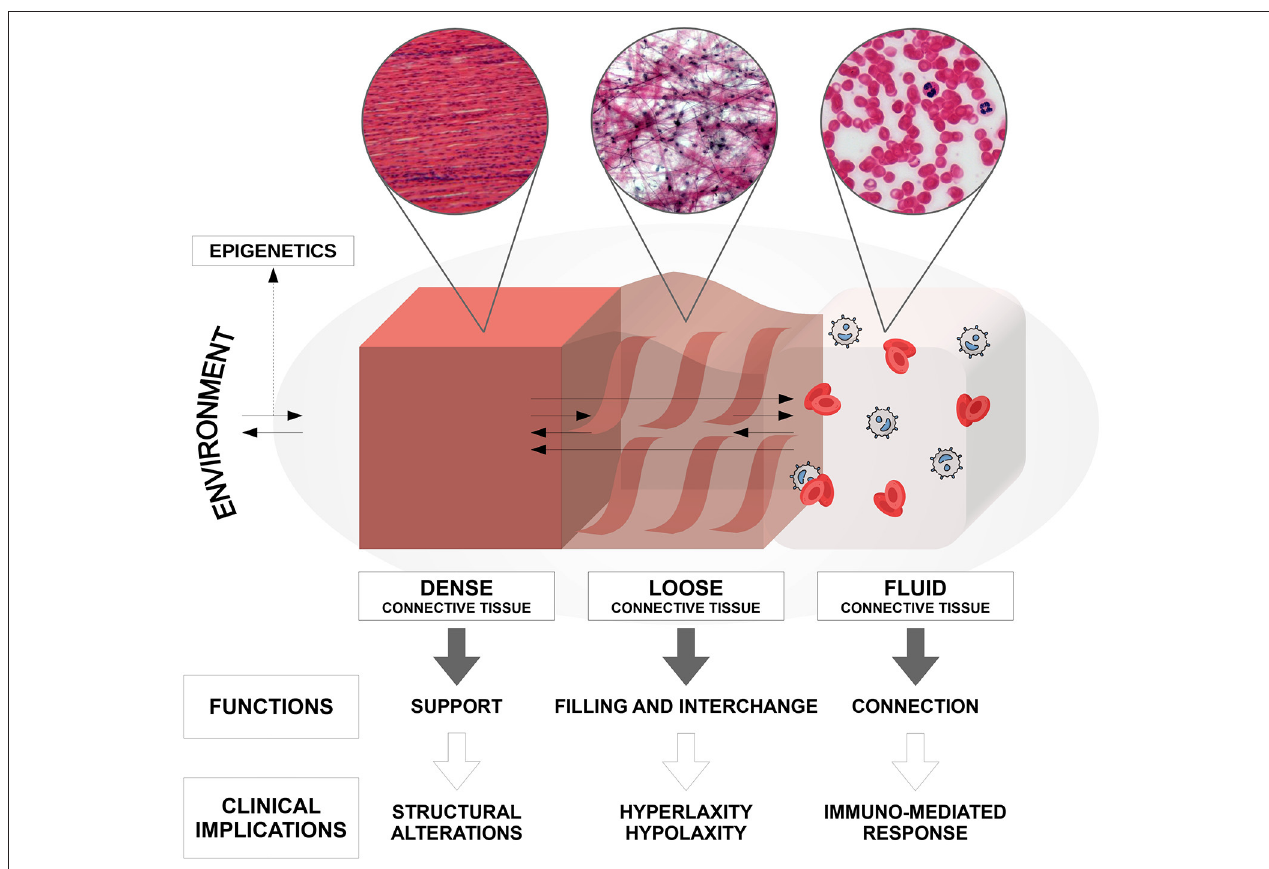
FIGURE 1 | Composition, anatomo-structural functions, and clinical implications of the connective tissue in the human body.